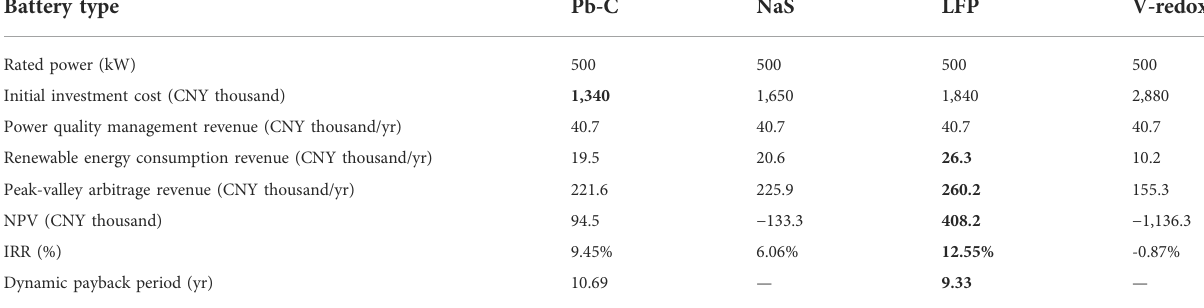
TABLE 2 Investment income analysis of energy storage system.